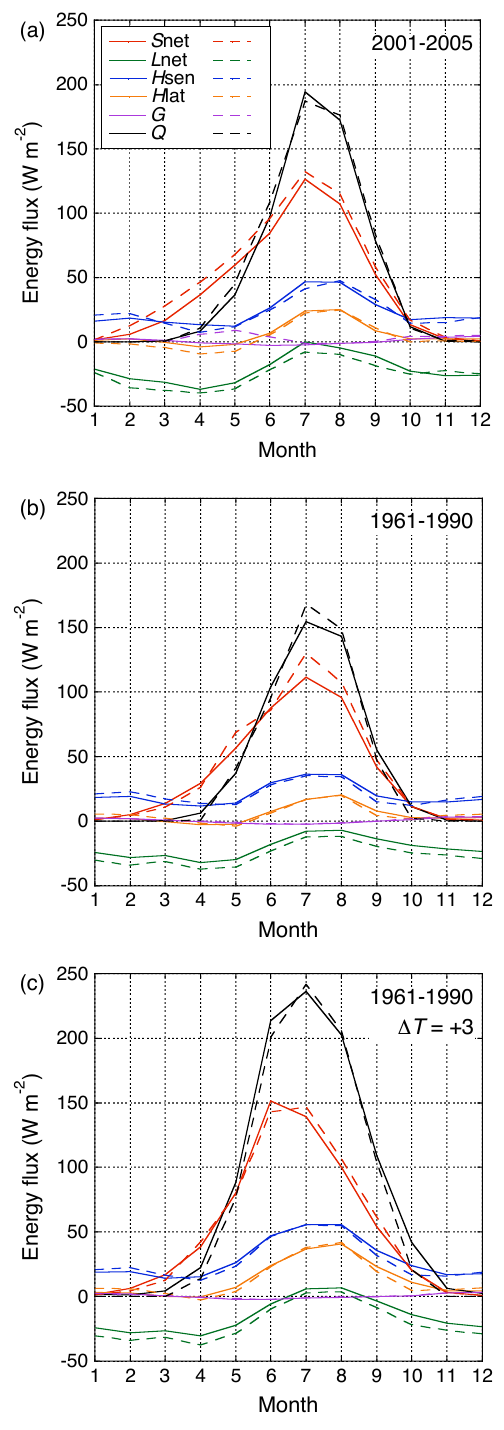
Fig. 4. Seasonal cycle of the surface energy fluxes at AWS1, modelled with the local meteorological records (solid lines) for (a) 2001–2005, (b) 1961–1990 and (c) 1961–1990 with 1T =+3 ◦ C. The dashed lines in (a) show the mean seasonal cycle of the AWS1 measurements for the same period, in (b) and (c) they show the re- sults of simulations with the control climate for 1961–1990.